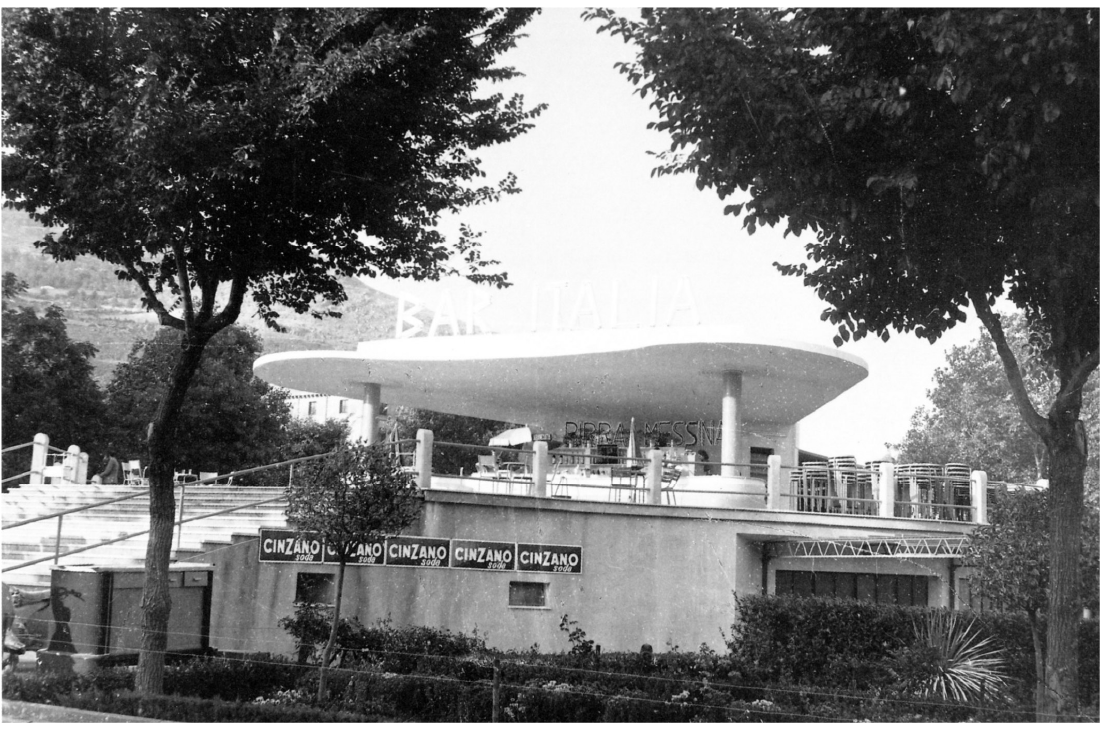
Figure 9. Bar Italia,